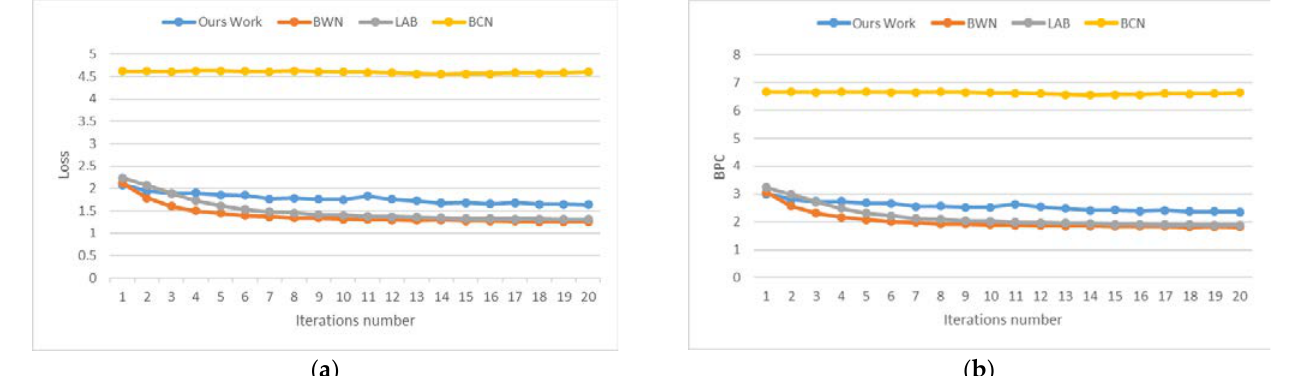
Figure 5. Comparison of the loss and BPC in the 1-bit quantization precision. ( a ) The 1-bit iteration curves of the loss. ( b ) The 1-bit iteration curves of the BPC.